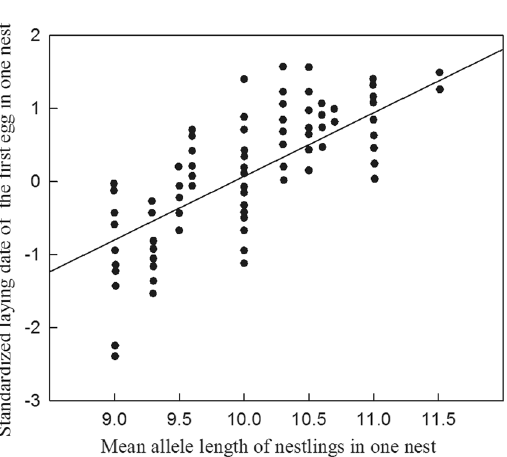
Figure 5. The correlation between mean Clock poly-Q allele length of the nestlings in one nest and the standardized laying date of the first egg in one nest (n = 240; r = 0.559; P <